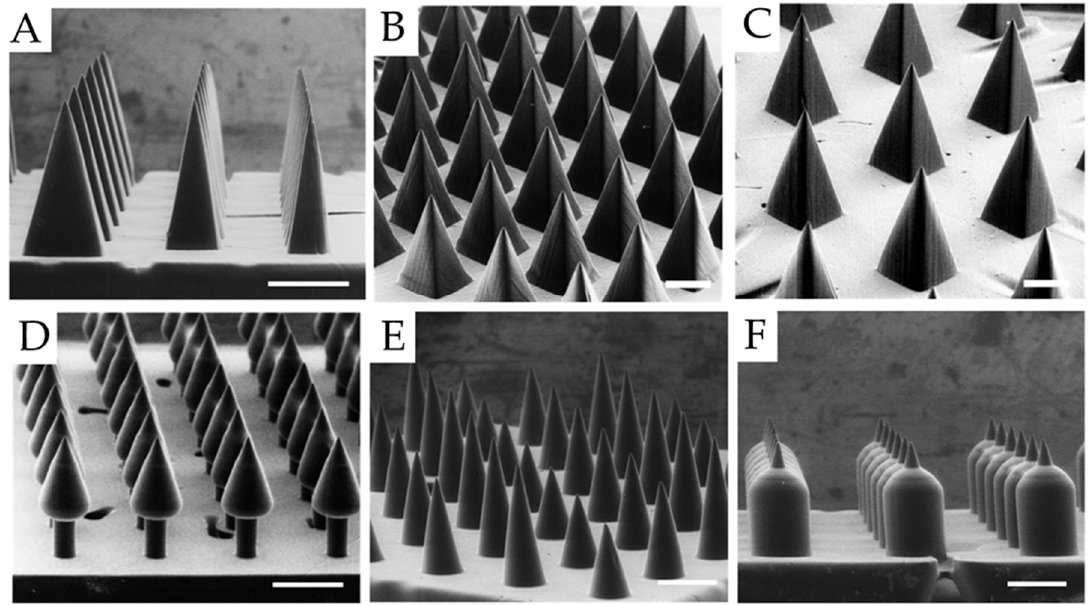
Figure 4. Microneedle providing minimally invasive delivery. Additive manufacturing brings enhanced flexibility, as shown in arbitrarily shaped microneedle arrays ( A – F ) [28]. Scale bars: 500 µm ( A – F ). Reproduced with permission from PLOS.